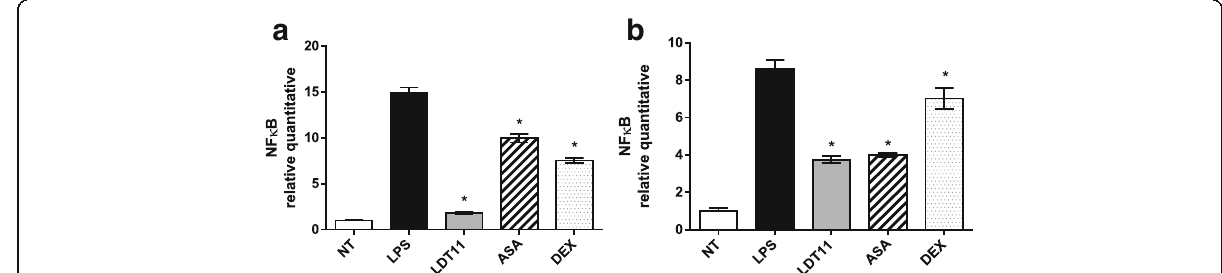
Fig. 8 Determination of the relative amount of NF-kB gene transcripts in RAW 264.7 cell line for the evaluation of inflammatory response at 6 ( a ) and 24 h ( b ) post-stimulus. NT- untreated cells; LPS - LPS-stimulated cells; LDT11 - cells treated with LDT11 and then with LPS; AAS - cells treated with commercial acetylsalicylic acid and then with LPS; DEX - cells treated with the commercial anti-inflammatory Dexamethasone and then with LPS. All data are from at least three independent experiments, * p < 0.05, statistically different compared with cells